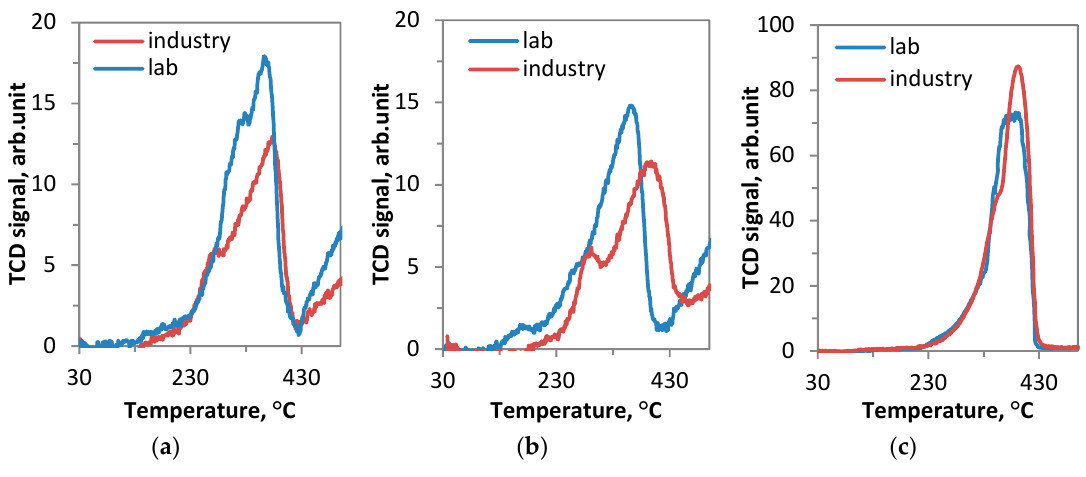
Figure 6. TPR-H 2 of the laboratory and commercially prepared catalysts: ( a ) K/Co 4 MnAlO x ; ( b ) Cs/Co 4 MnAlO x ; ( c ) Cs/Co 3 O 4 .